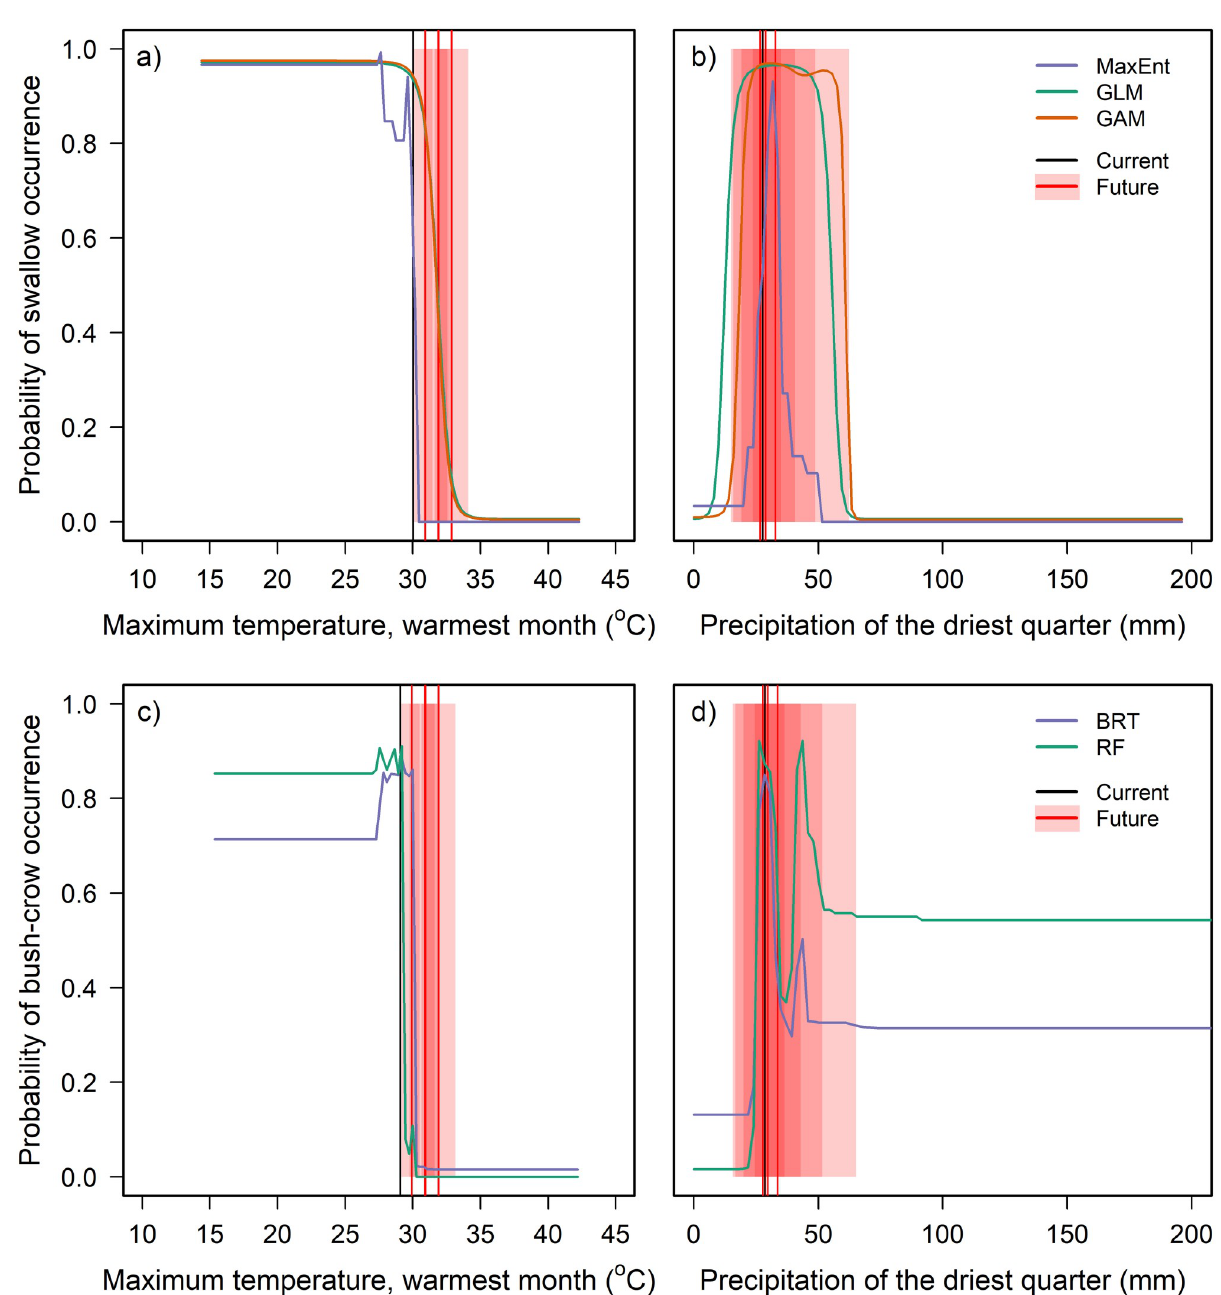
Fig 4. The relationship of modelled partial probability of occurrence of a+b) White-tailed Swallow and c+d) Ethiopian Bush-crow to a+c) maximum temperature of the warmest month and b+d) precipitation of the driest quarter, compared to current and future projected mean values. Black vertical lines indicate the current mean value of each bioclimate variable [41] within a convex hull fitted around each species’ distribution. Red vertical lines show the projected mean value in 2070 for each of four Representative Concentration Pathways (RCP) (IPCC 2014). Red shading shows the range of projected mean values across six Global Circulation Models for each RCP, and appears darker where these ranges overlap (therefore corresponding to more likely scenarios). See Fig 3 for further details on response curves.